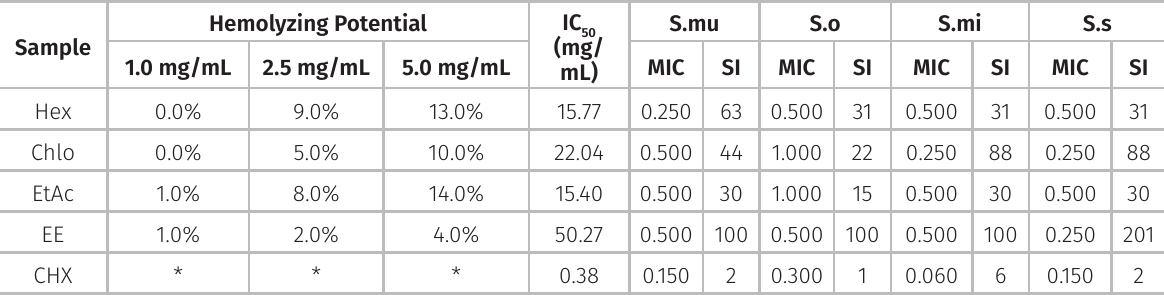
Table I. Hemolyzing Potential, IC , Minimum Inhibitory Concentration (MIC – mg/mL) and Selectivity Index (SI) of 50 tested solutions.